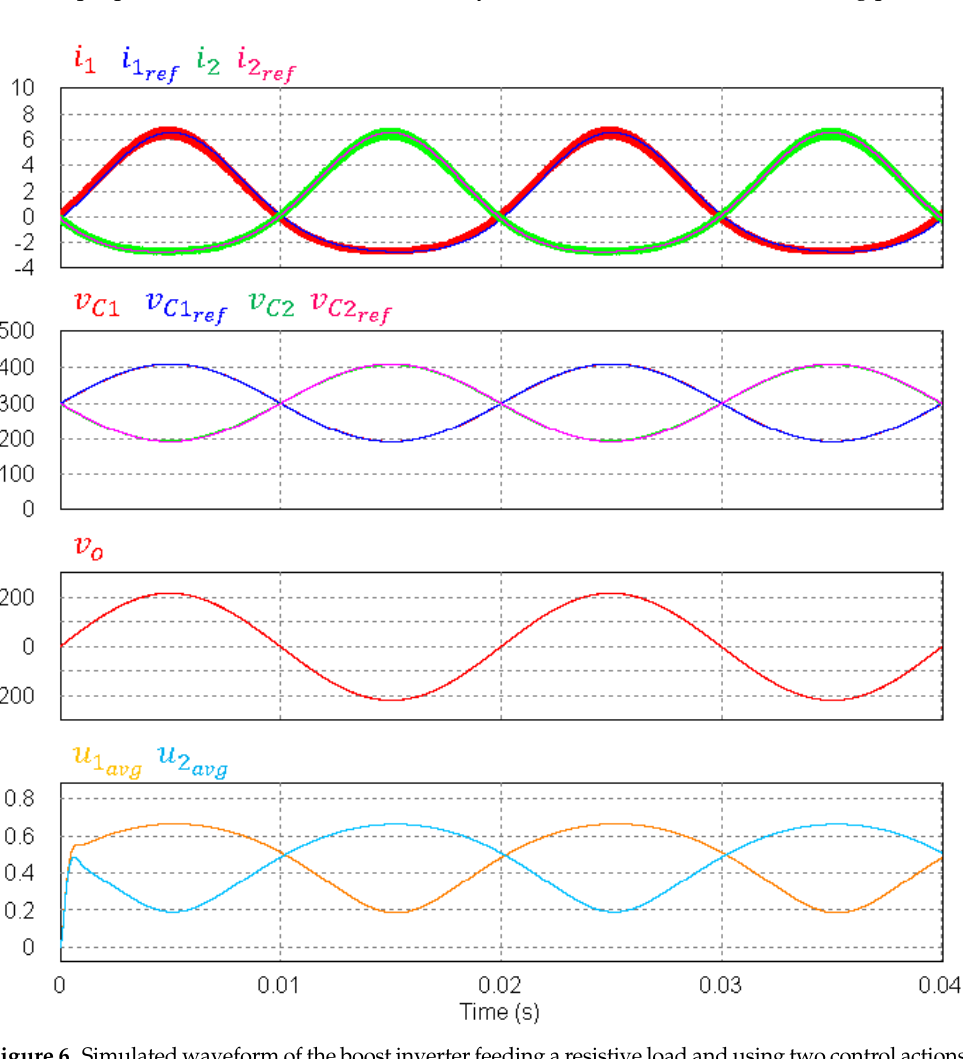
Figure 6. Simulated waveform of the boost inverter feeding a resistive load and using two control